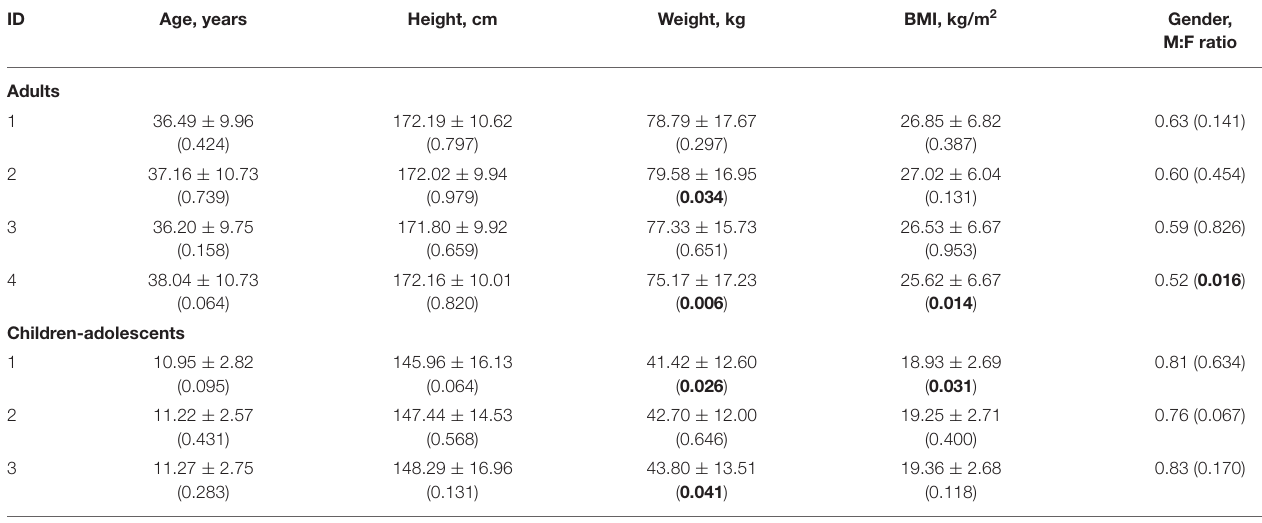
TABLE 7 | Results of the comparison analysis between demographic characteristics within the clusters. ID Age, years Height, cm Weight, kg BMI, kg/m 2 Gender,